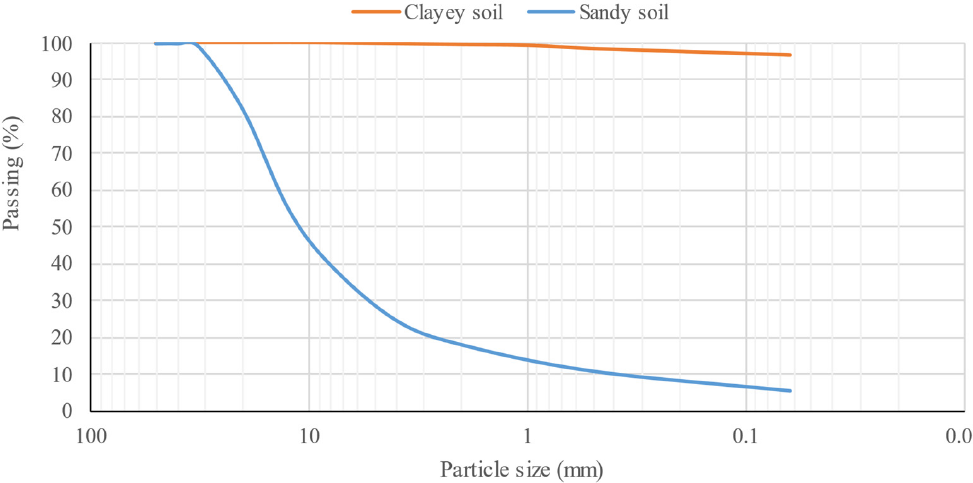
Table 1. Physical and chemical properties of CS and SS.